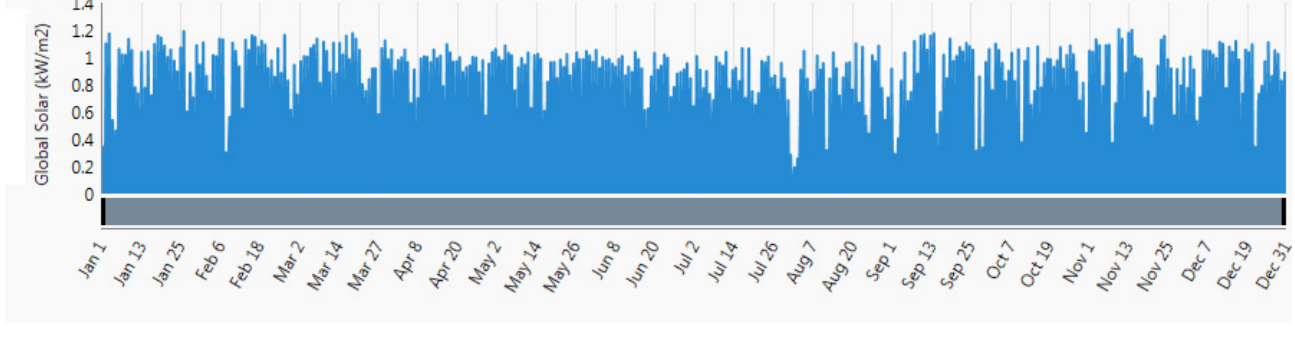
Figure 5. Calculated hourly solar radiation, kW h/m 2 .